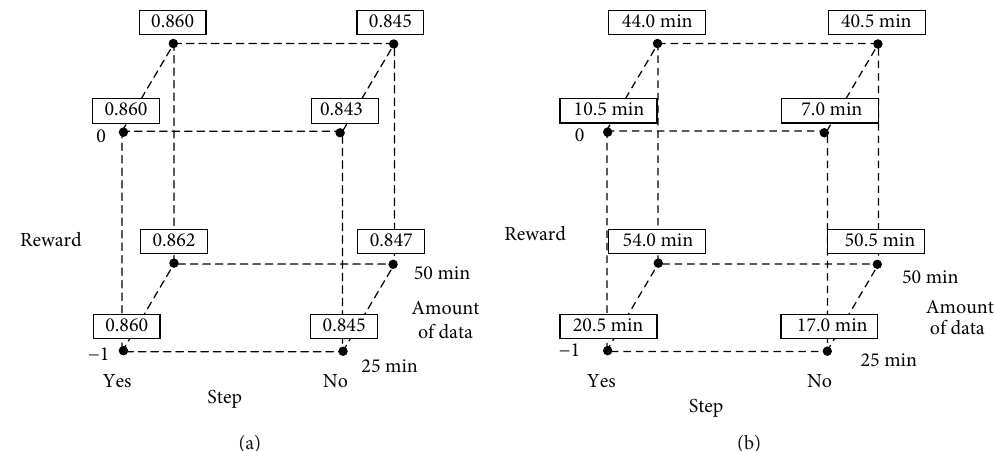
Figure 5: Cube plot of the factors in fl uences on the (a) average reward and (b) time with the vehicle velocity included in the state